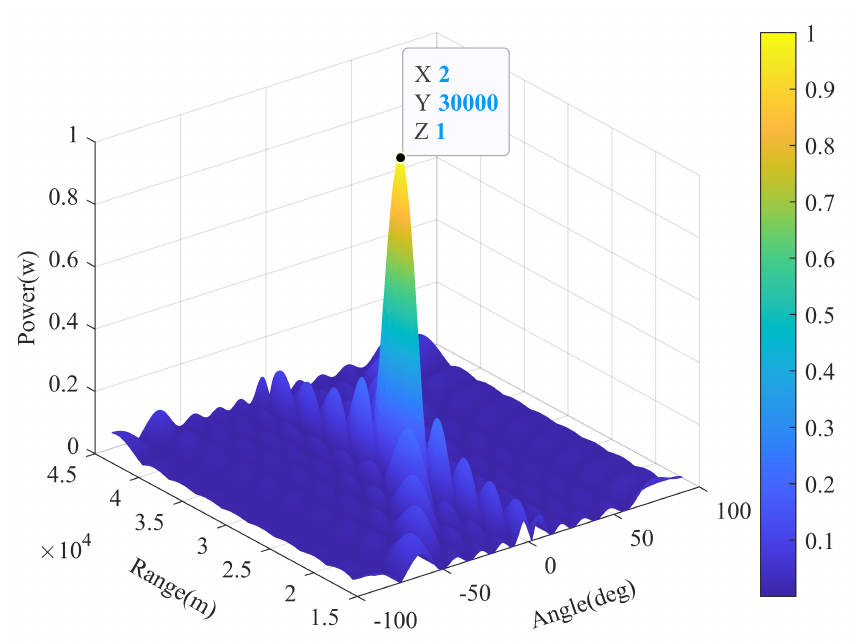
Figure 5. Values of H when ( r k , θ k ) deviates from ( r l , θ l )